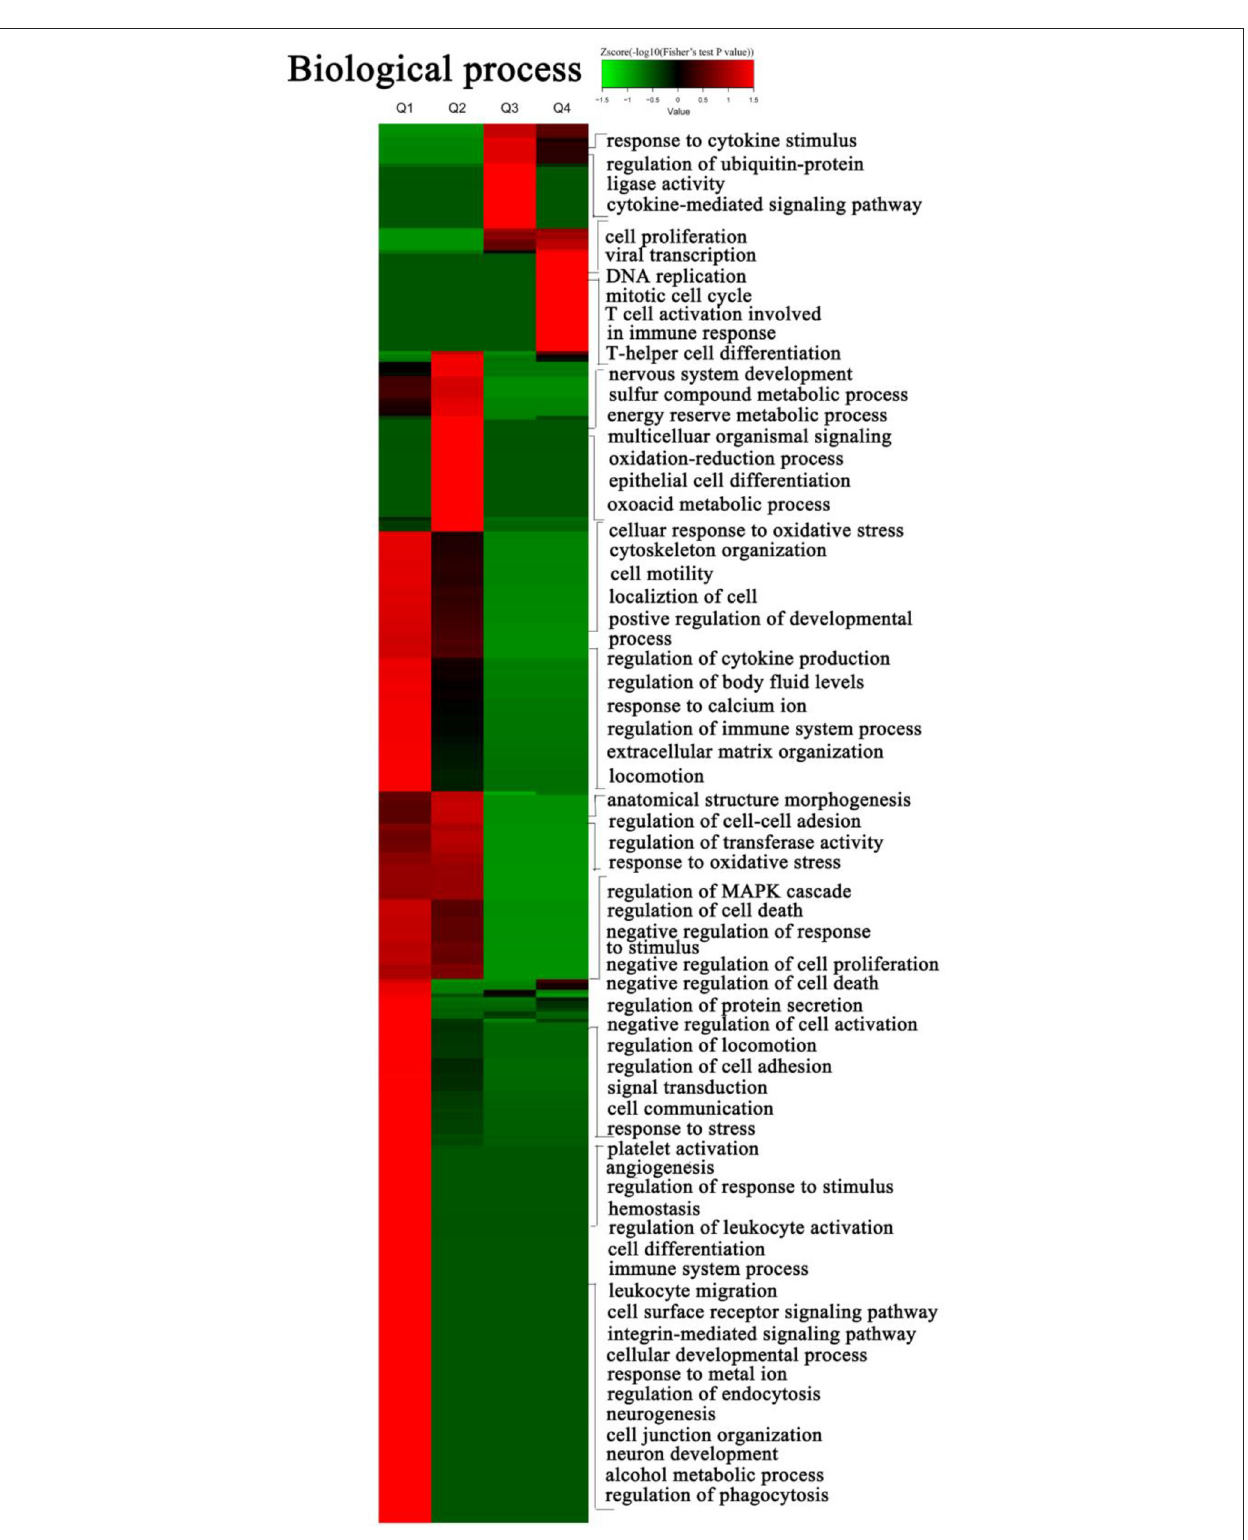
Frontiers in Immunology |